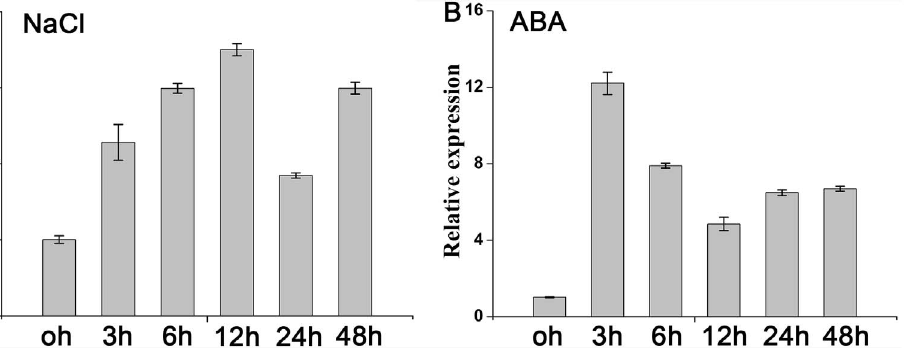
Fig. 3. Expression analysis of the IbMas gene in sweetpotato line ND98 by real-time quantitative PCR. (A) and (B) Relative expression level of IbMas in ND98 after different times (h) of 200 mM NaCl and 100 m M ABA treatment, respectively. The 4-week-old in vitro-grown plants of ND98 were submerged in 1/2 MS medium containing 200 mM NaCl and 100 m M ABA, respectively, and sampled at 0, 3, 6, 12, 24 and 48 h after treatment to analyze the expression of IbMas . The sweetpotato b -actin gene was used as an internal control. Data are presented as means ¡ SE (n 5